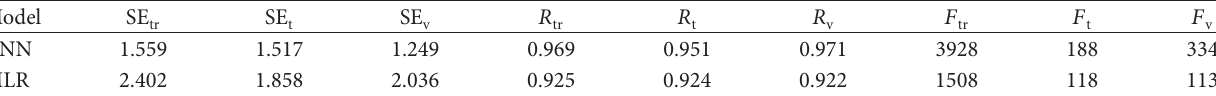
T 4: Statistical parameters obtained using the ANN and MLR models.